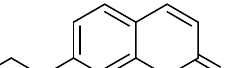
Figure 6. Chemical s tructure of 7-(diethylamino)-2 H -chromene-2-thione.